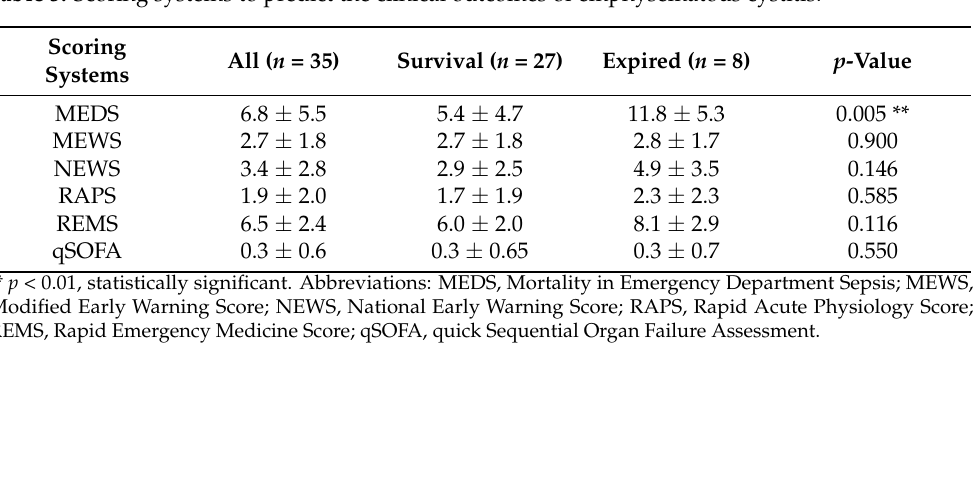
Table 3. Scoring systems to predict the clinical outcomes of emphysematous